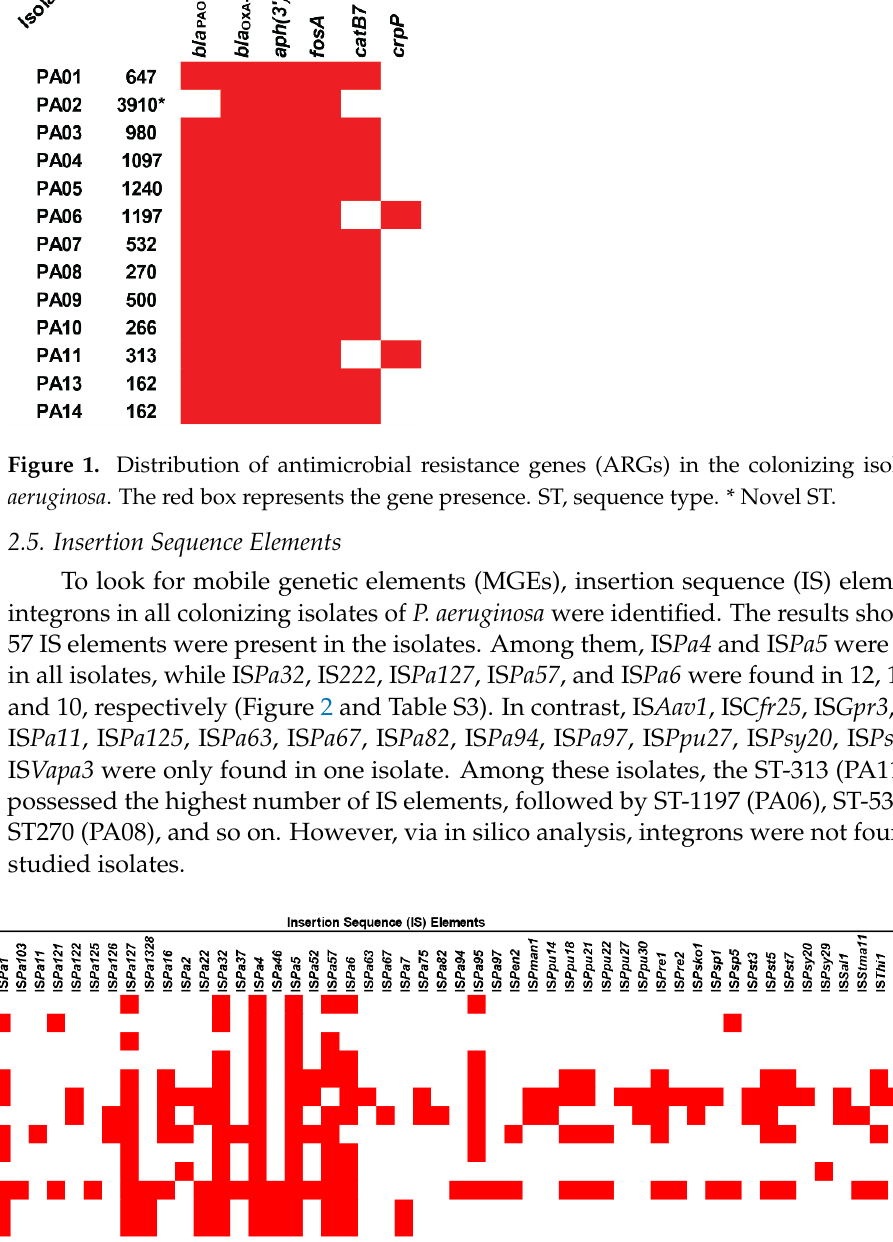
Figure 2. Distribution of insertion sequence (IS) elements in the colonizing isolates of P. aeruginosa . The red box represents the gene presence. ST, sequence type. * Novel ST.